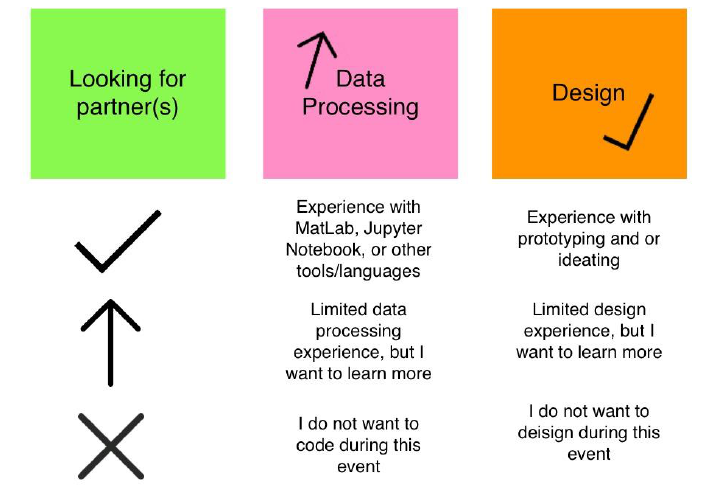
Figure 5. Match Making Post-it Notes.